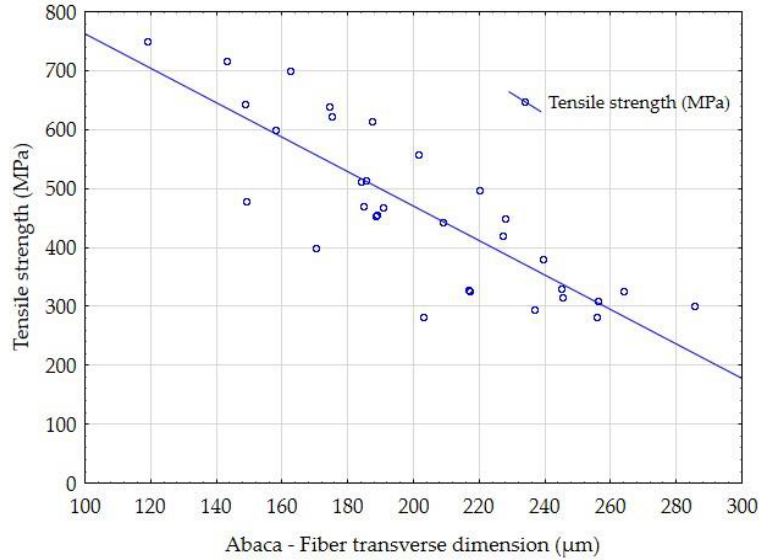
Figure 12. Comparison of the influence of the fiber transverse dimension of the abaca fibers on the tensile strength.